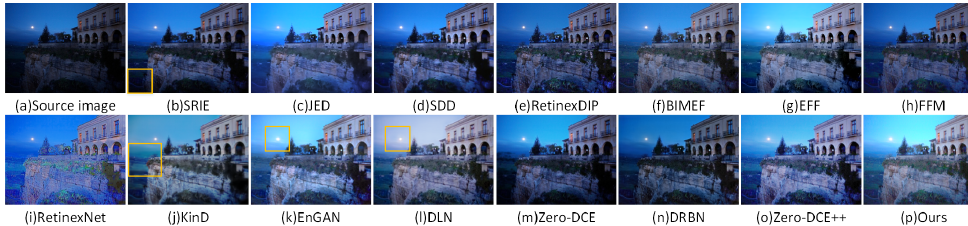
Figure 12. Comparison of the visual effect of the enhanced night view images in the LIME [38]